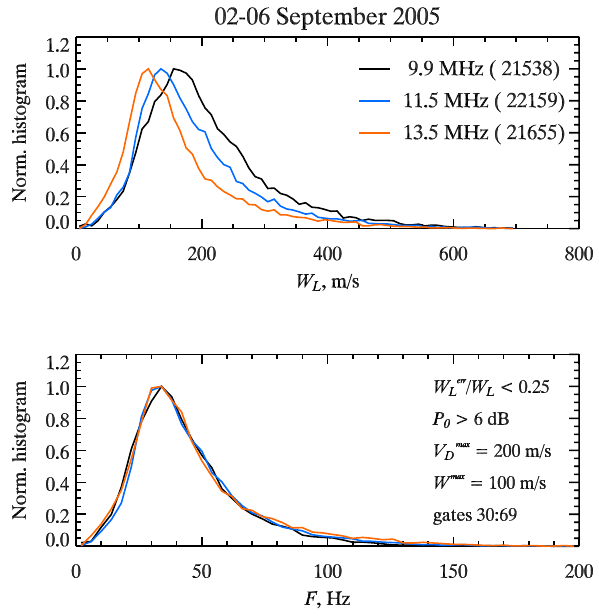
Fig. 9. Normalized F-region scatter histograms (MLAT ≥ 70 ◦ ) for 2–6 September 2005.